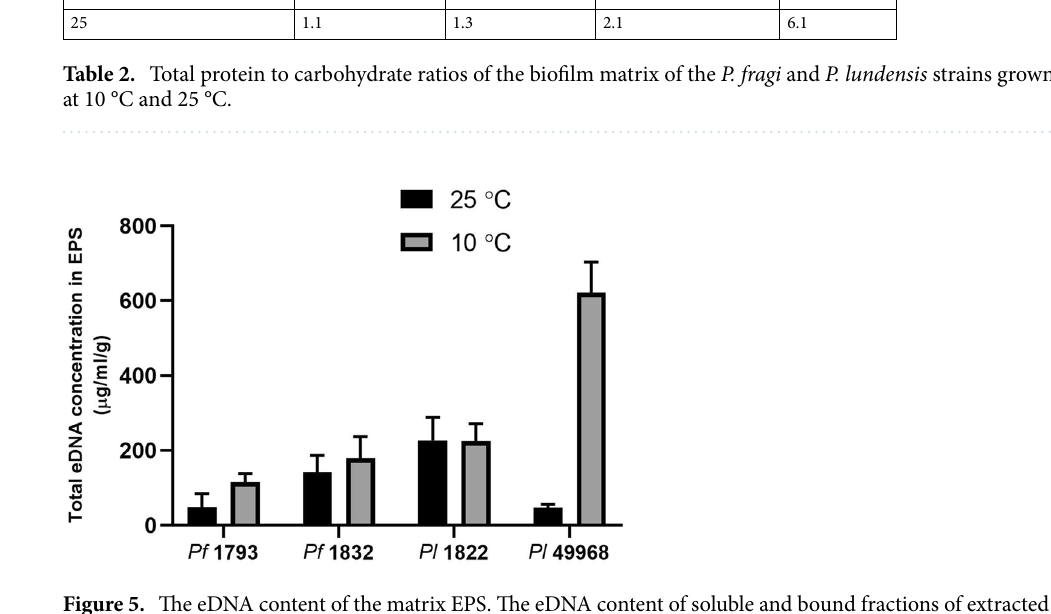
Figure 5. The eDNA content of the matrix EPS. The eDNA content of soluble and bound fractions of extracted EPS of P. fragi (1793 and 1832) and P. lundensis (1822 and ATCC 49968) biofilms formed on nitro-cellulose membrane placed on meat at 10 °C and 25